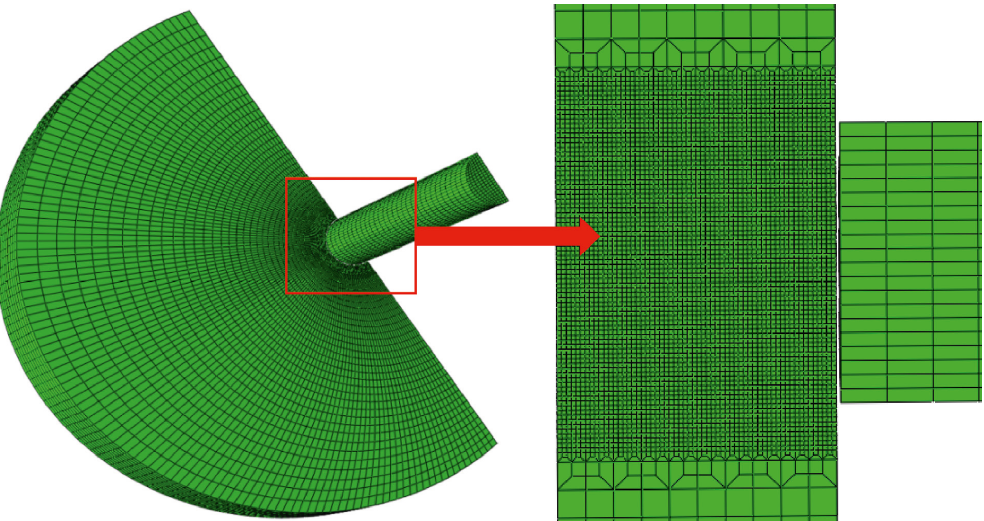
Figure 12: Finite element model of ballistic test for Q235B steel